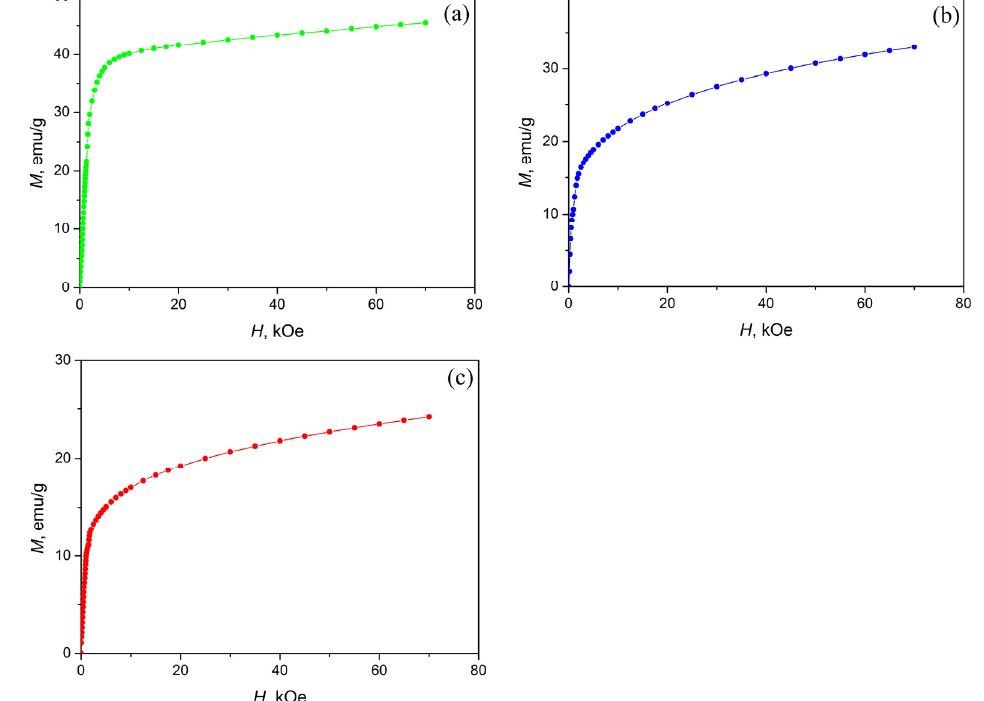
Figure 6. Field dependences of magnetization M ( H ) at T = 4.2 K: ( a ) Ni 45 Mn 43 In 12 , ( b ) Ni 46 Mn 42 In 12 , ( c ) Ni 47 Mn 41 In 12 .